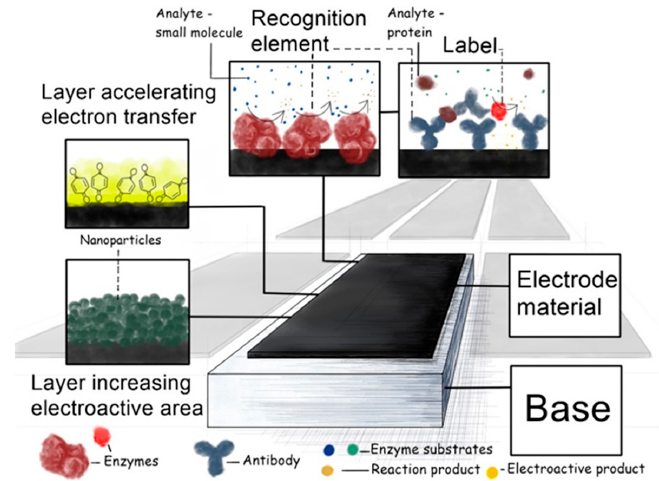
Figure 5. Schematic representation of the possible parts of the MSS/MSA.